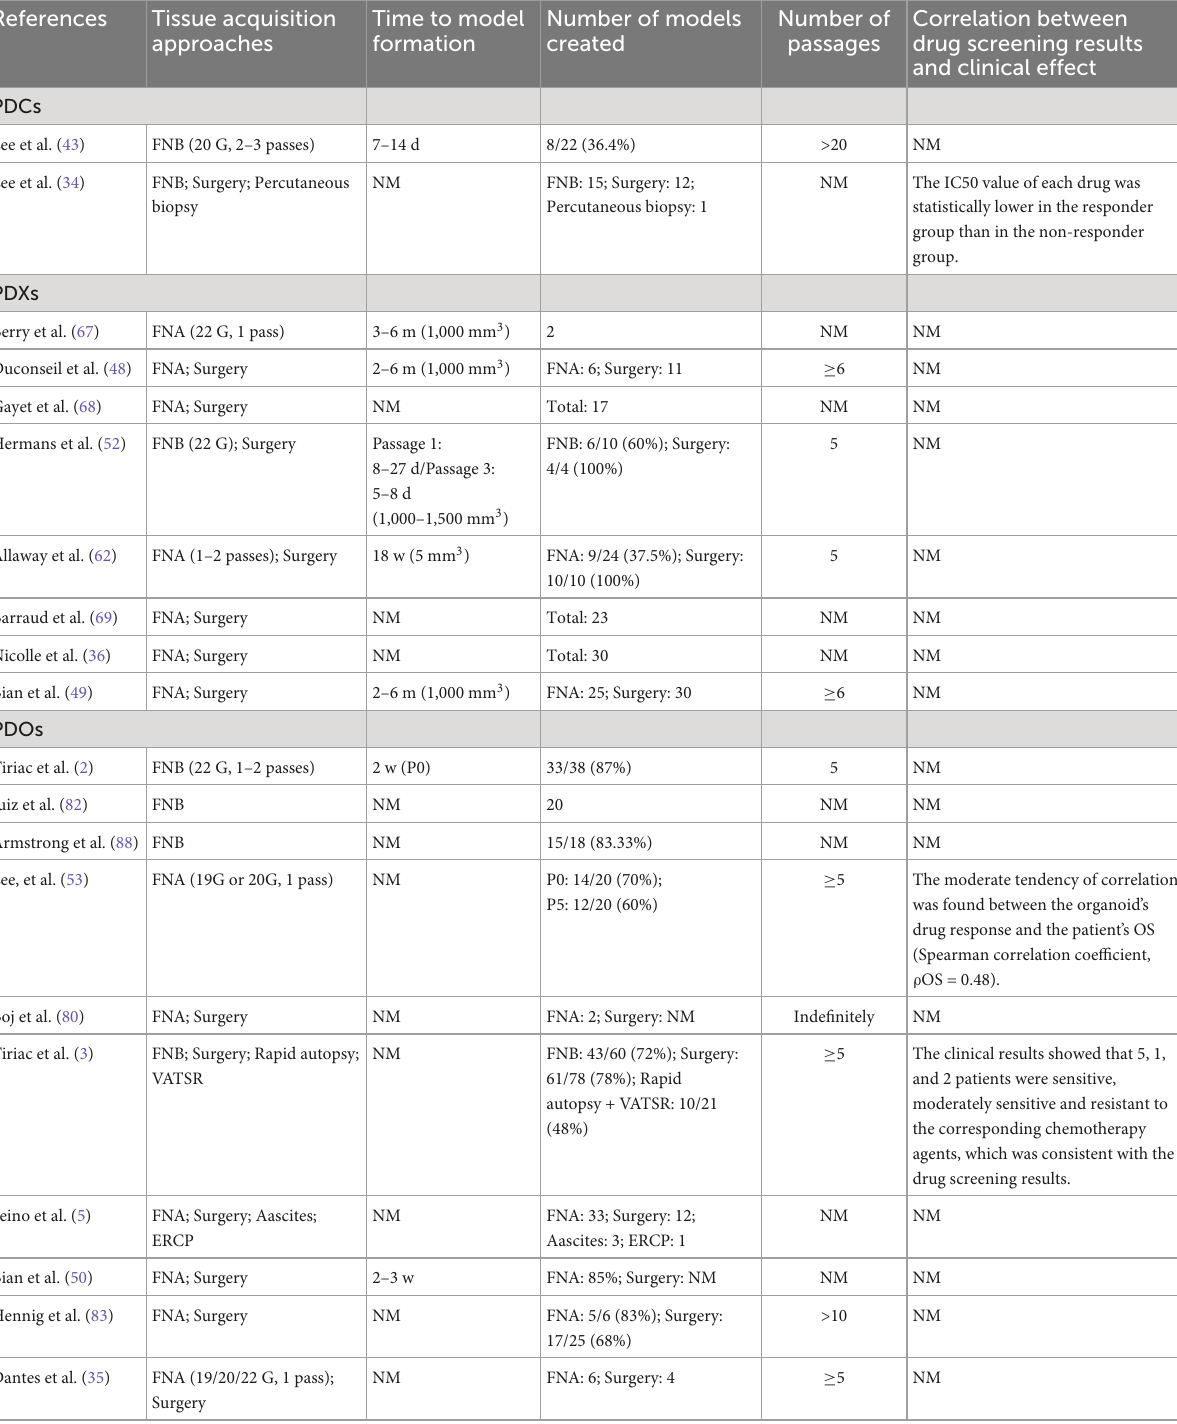
TABLE 2 Data on the establishment of preclinical models for pancreatic ductal adenocarcinoma (PDAC) patients using endoscopic ultrasound-guided tissue acquisition (EUS-TA) alone and combined with other approaches as well as the accuracy of drug screening